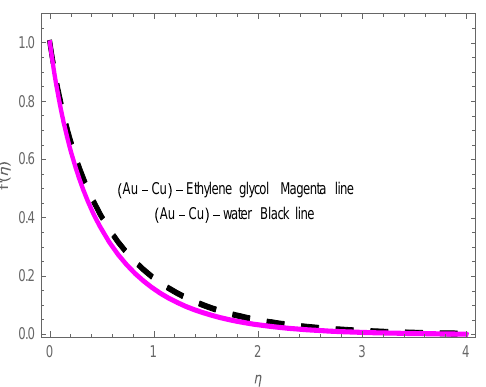
Figure 2. 𝑓 ′ (𝜂) for (Au-Cu)/Water and (Au-Cu)/Ethylene hybrid nanofluids.